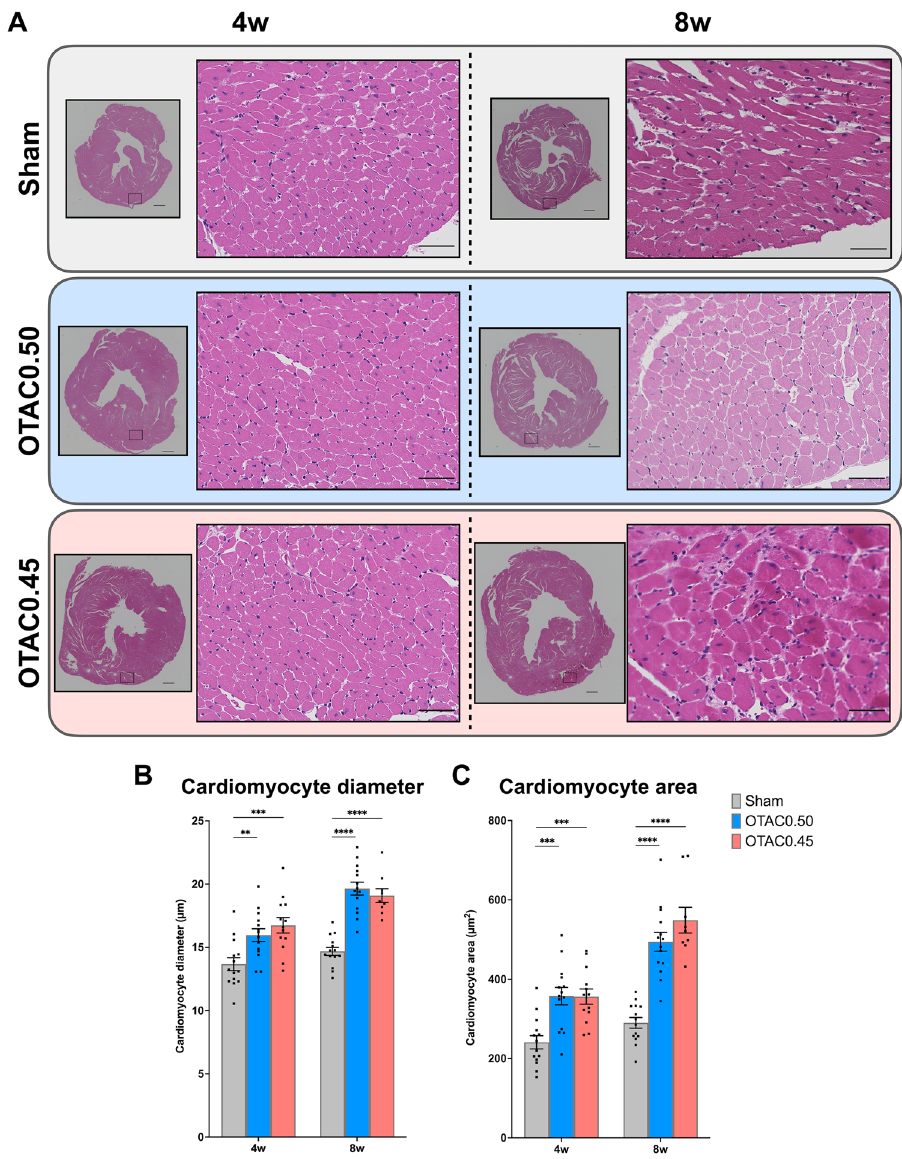
Figure 5. Cardiac histology at 4 and 8 weeks post-procedure. ( A ) Representative images of short-axis cardiac sections with hematoxylin and eosin staining in Sham and OTAC. Left: 4 × magnification of left ventricular at mid-ventricular sections. Scale = 500 µm. Right: 40 × magnification of a representative area. Scale = 100 µm. ( B ) Quantification of cardiomyocyte diameter of the short axis. ( C ) Quantification of cardiomyocyte area. Comparison among groups was performed by one-way ANOVA with Tukey’s post hoc tests; n = 9–14. ** P < 0.01; *** P < 0.001; **** P <